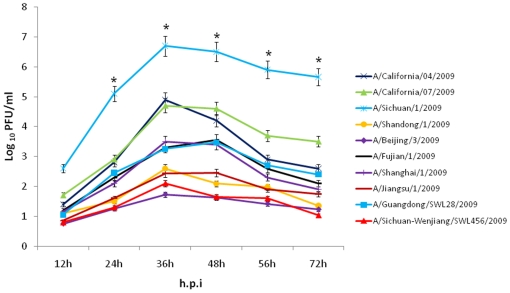
Replication kinetics of the ten 2009 pandemic A (H1N1) influenza viruses in MDCK cells.Each data point represents the mean viral yield (log10 PFU/ml) from three individually infected wells ± SD. *P<0.05 compared to the values of other viruses (one-way ANOVA).